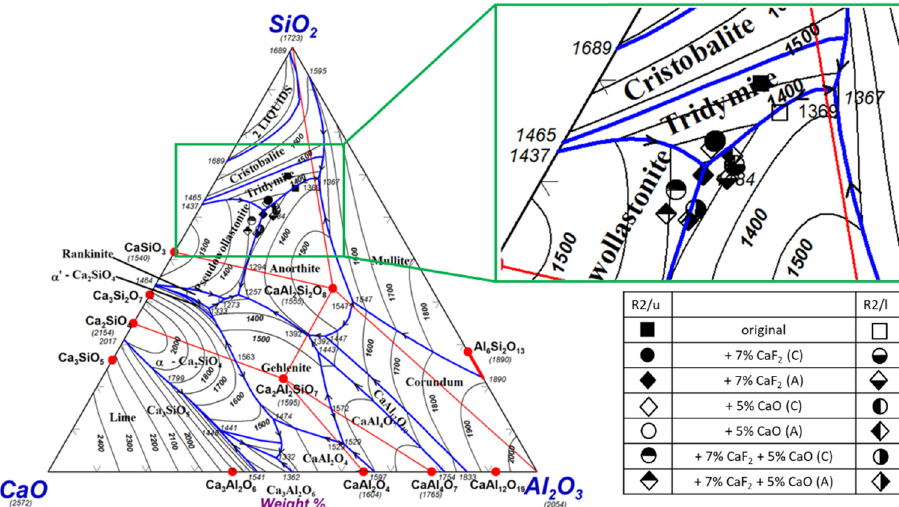
Figure 9. Ternary Al 2 O 3 -CaO-SiO 2 phase diagram with the target liquidus temperature area (<1300 °C) displayed in the close-up view. Original and modified slag compositions from R2/u and R2/l concentrates computed and plotted with FactSage version 7 and its FToxid database. C = calculated from ICP-OES data and A = calculated from EPMA analysis data.